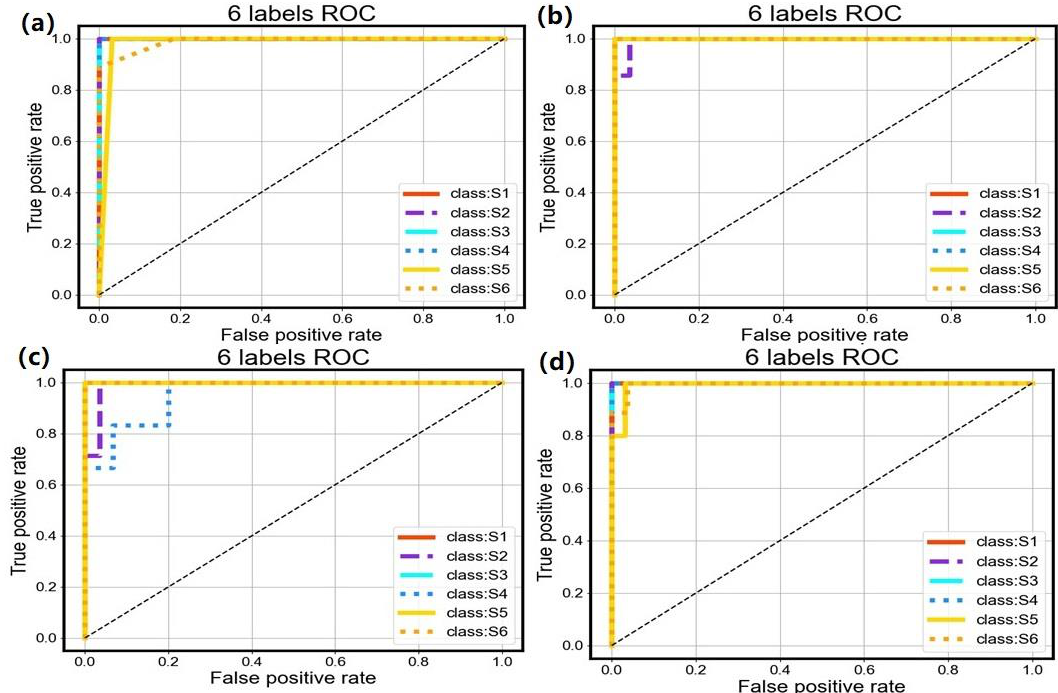
Figure 8. Overall receiver operating characteristics (ROC) curve of XGBT showing the true positive